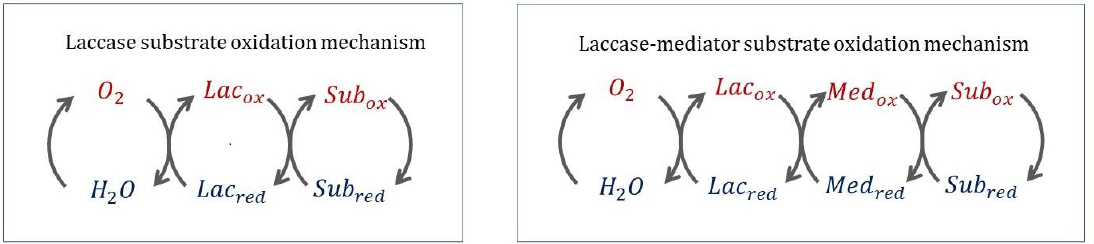
Figure 7. Laccase-mediated catalytic cycles for substrate oxidation. On the left: the direct substrate oxidation. On the right: the same substrate oxidation in the presence of a mediator.